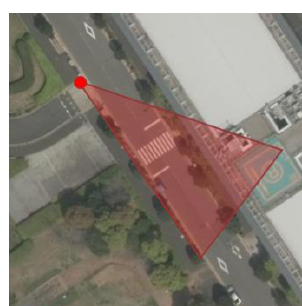
Figure 3. Three camera locations.